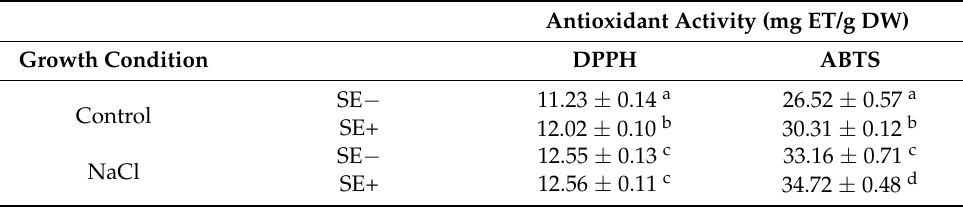
Table 5. Antioxidant activity in the tomato plants at the vegetative